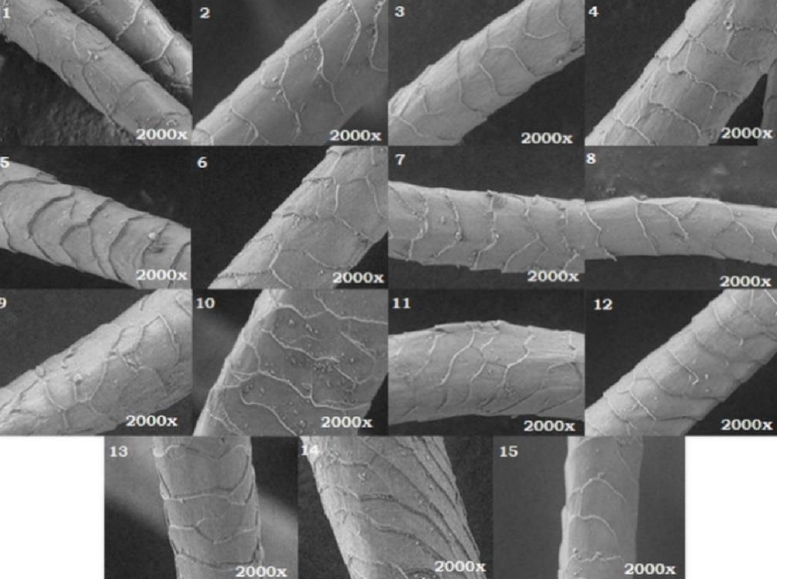
Figure 10. Scanning electron micrograph of ( 1 ) wool dyed with aqueous extract, ( 2 ) wool dyed with ultrasonic extract, ( 3 ) wool dyed with alcoholic extract, ( 4 ) wool dyed with acidic extract, ( 5 ) UV-irradiated wool dyed with aqueous extract, ( 6 ) UV-irradiated wool dyed with ultrasonic extract, ( 7 ) UV-irradiated wool dyed with alcoholic extract, ( 8 ) UV-irradiated wool dyed with acid extract, ( 9 ) wool treated with citric acid and dyed with aqueous extract, ( 10 ) wool treated with citric acid and dyed with ultrasonic extract, ( 11 ) wool treated with citric acid and dyed with alcoholic extract, ( 12 ) wool treated with citric acid and dyed with acid extract, ( 13 ) wool treated with citric acid, ( 14 ) UV-irradiated wool, and ( 15 ) untreated wool.